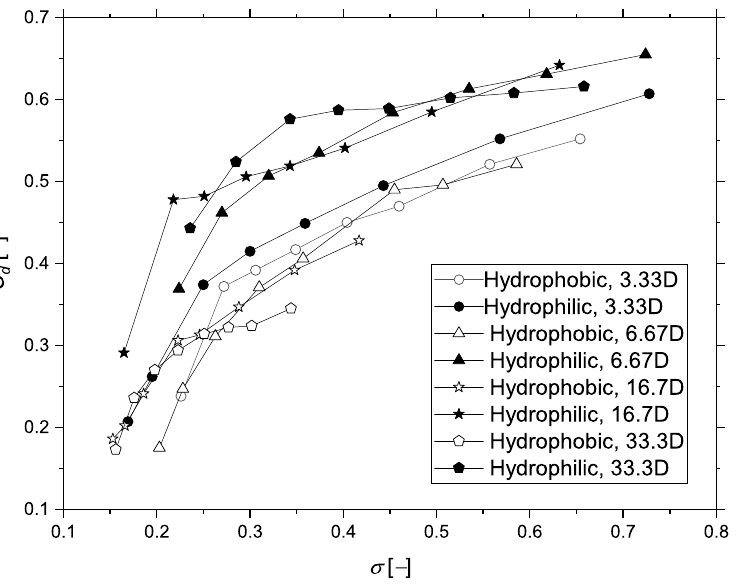
Figure 12. Relationship between drag coefficient and cavitation number for different conditions. In order to study the effect of surface coating on the ballistic stability of the projectile, Figures 13 and 14 show the relationship between the deflection angle of the projectile and the deflection angular rate of the projectile with time under different working conditions. The counterclockwise deflection was positive and the clockwise deflection was negative. The error of the deflection angle was about 0.2 ◦ .